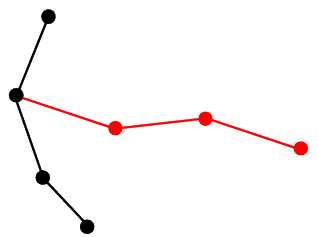
Figure 3. A new residential street (red) being created and connected to an existing one